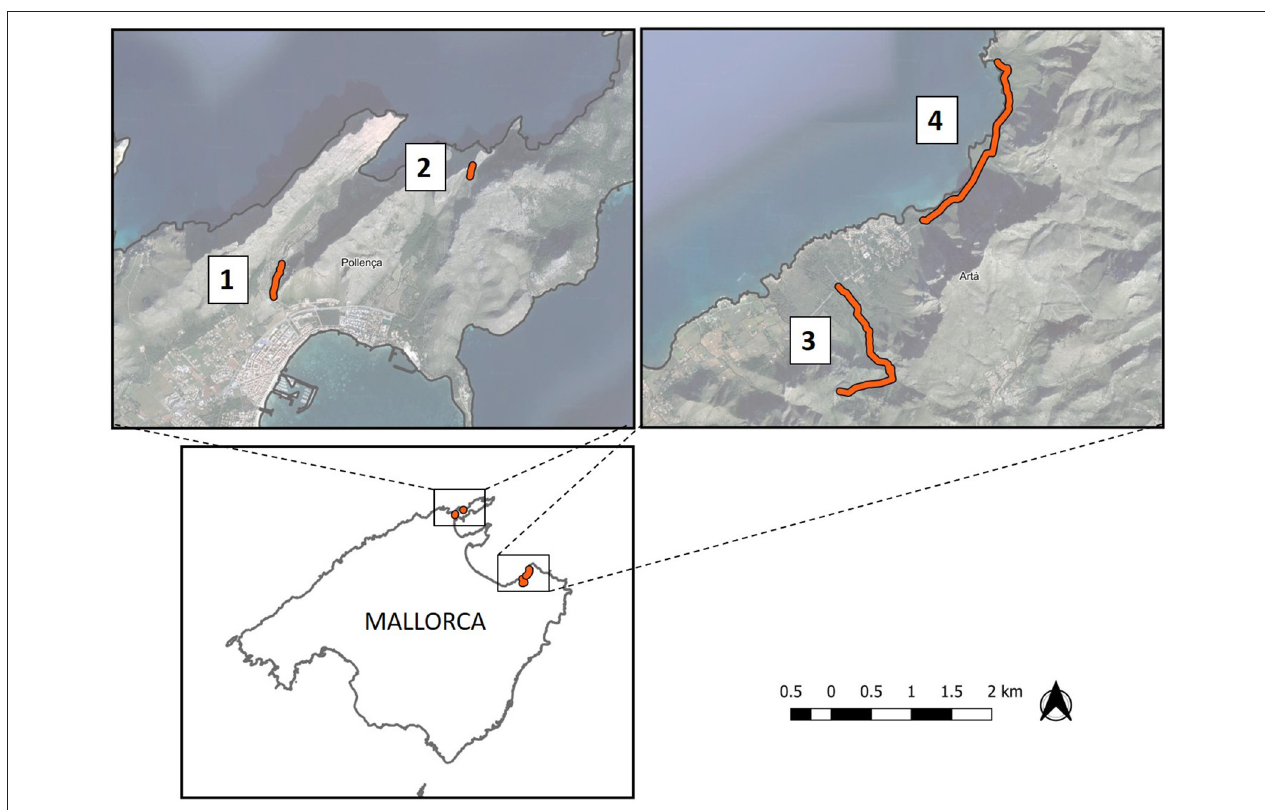
FIGURE 1 | Study area located in the Northeast of the Mallorca island. Orange lines are the four linear transects used for the fecal and regurgitation sampling surveys: (1) Cala Bóquer, (2) Cap de Formentor, (3) Ermita de Betlem, (4) Es